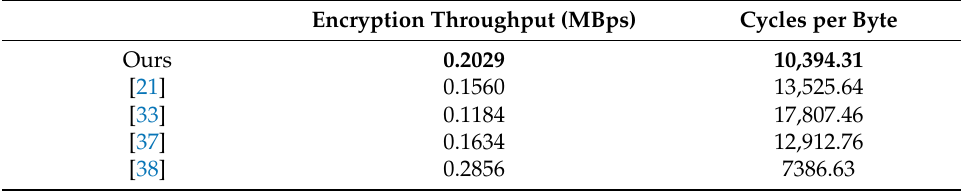
Table 7. A comparison of the efficiency of different algorithms. Encryption Throughput